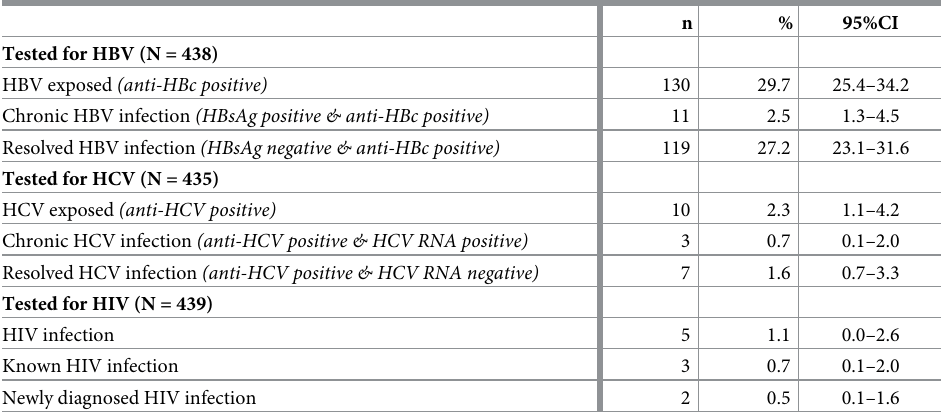
Table 2. Infectious disease status of participants who had blood draw (N = 435–439 �